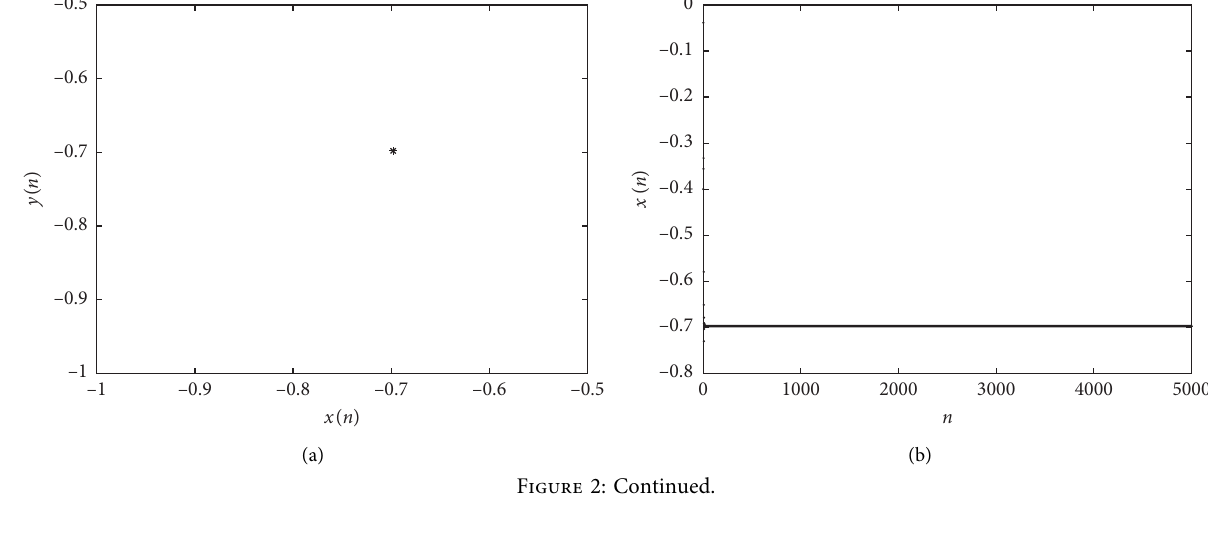
, (b) the bifurcation diagram with x 01